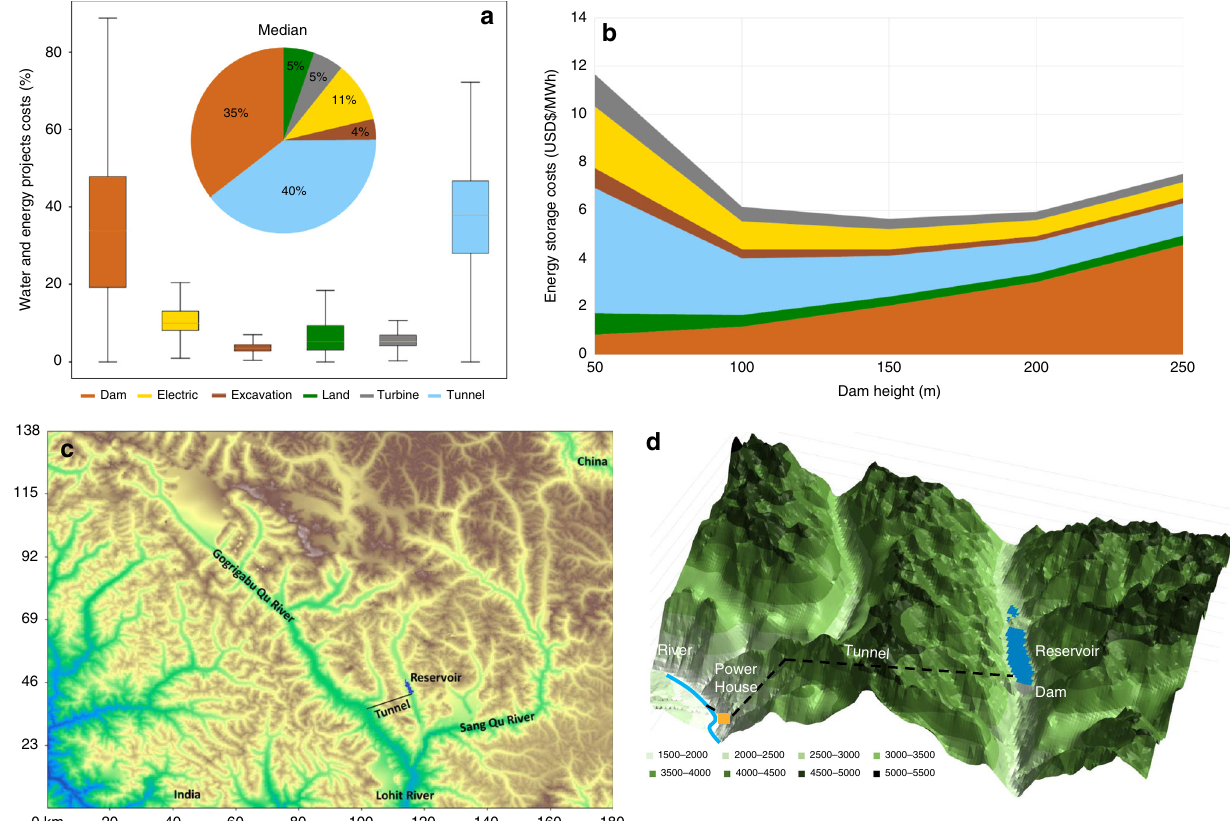
Fig. 1 Seasonal pumped hydropower storage (SPHS) costs and description. a Water and energy SPHS project cost distribution shows that the most expensive components tend to be the tunnel and dam. b Example of energy storage cost variation with cascade according to different heights for the example project in c . The energy storage cost reduces with the increase in dam height due to economies of gains, however, it then increases because the reservoir becomes larger than the amount of water available to be sustainably stored. c Presentation of selected project in Tibet, China, on a topographic map, presenting its tunnel in black and reservoir in purple. d Zoom in the selected